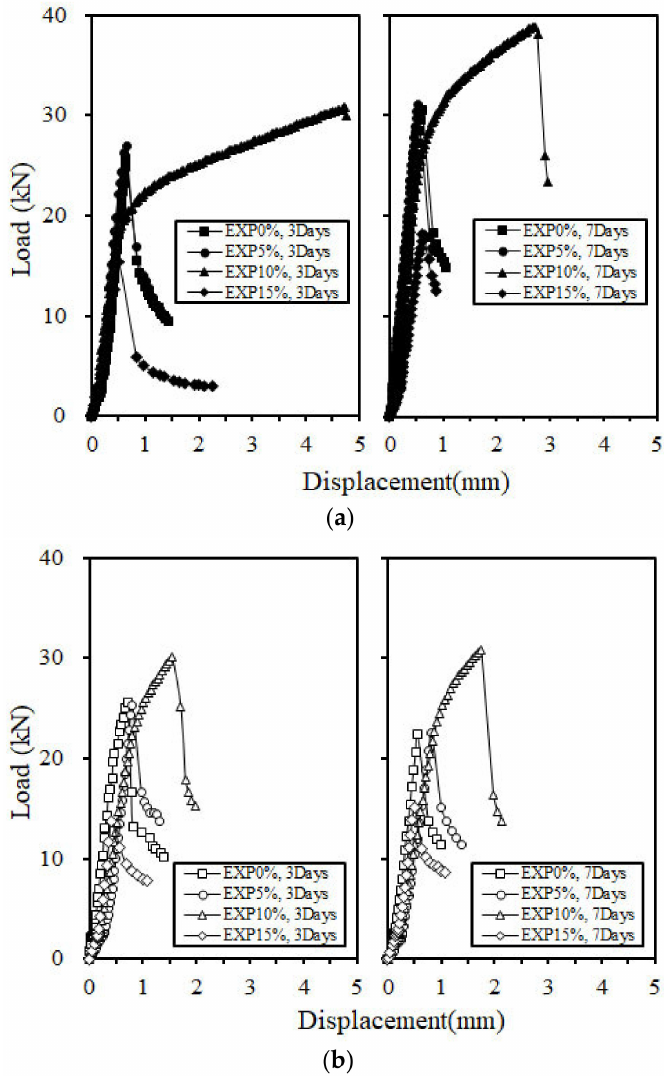
Figure 4. Load–displacement curves: ( a ) W/B of 70% and ( b ) W/B of